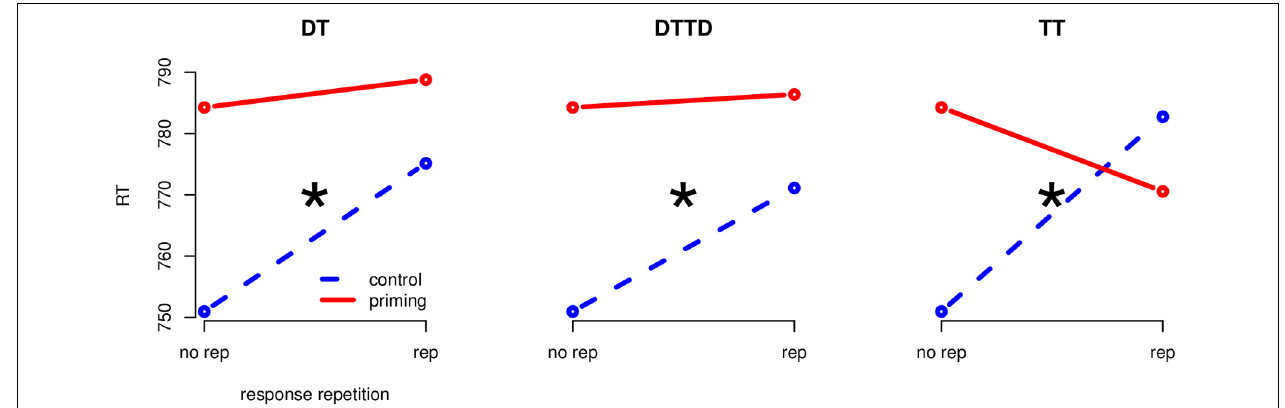
FIGURE 3 | Separate interaction plots for all priming conditions (Experiment 2). Blue, stippled line is the control condition, red solid line the corresponding priming condition. The “ ∗ ” indicates significance at the 0 . 05